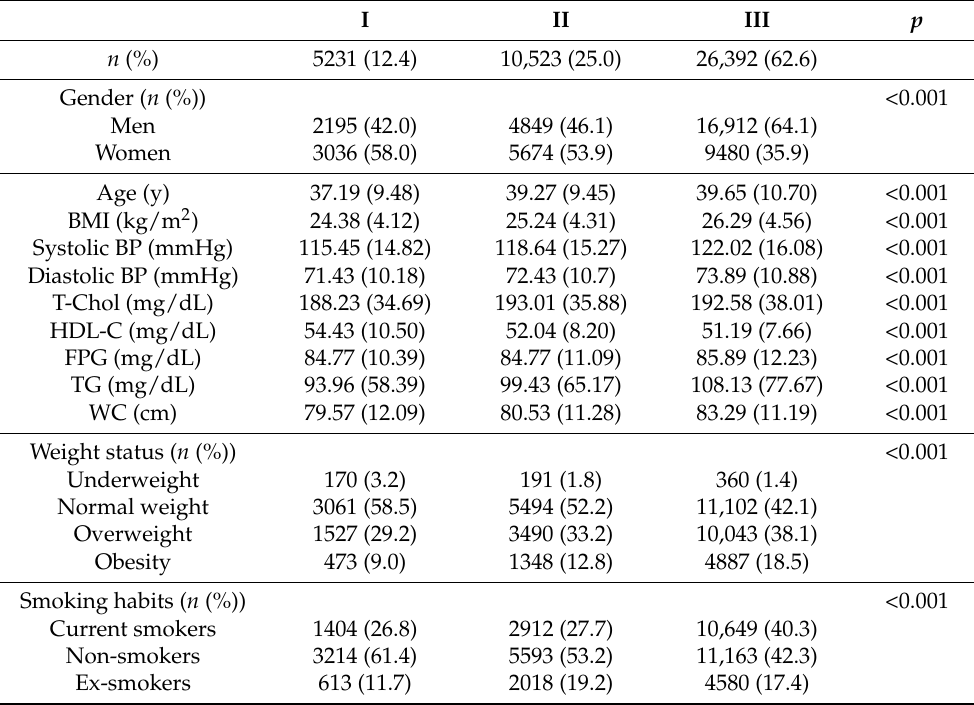
Table 2. General characteristics of study sample stratified by social